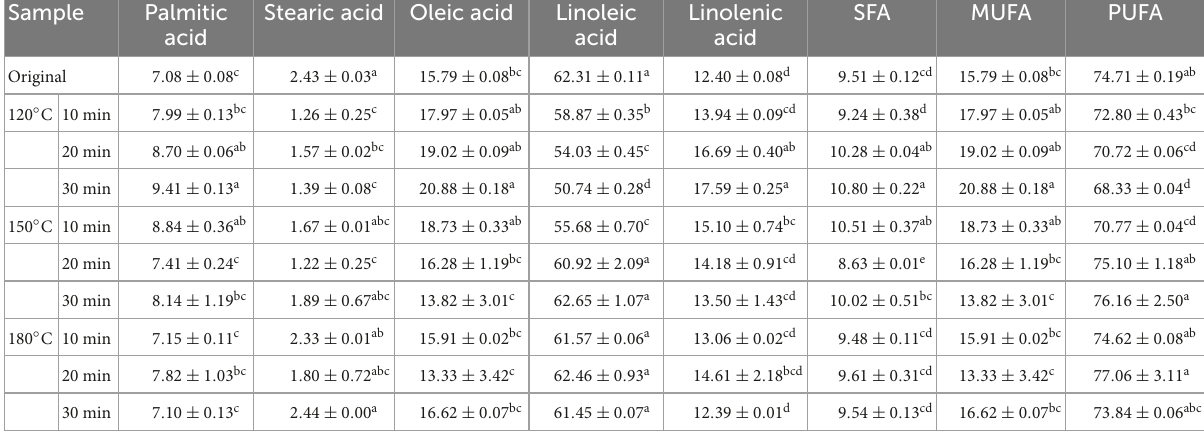
TABLE 1 Fatty acid composition (%) of walnut oil by roasted walnut kernels with different temperature and duration. Sample Palmitic Stearic acid Oleic acid Linoleic acid